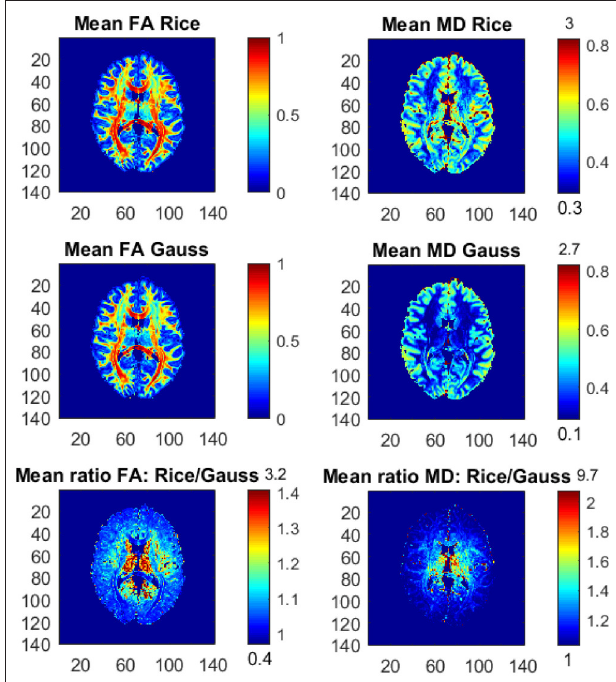
FIGURE 4 | Posterior means and ratios of posterior means of FA and MD for the Rician and Gaussian DTI models, using the part of the dataset with all b -values up to b = 5,000 s/mm 2 . The color bars are shown for the mid 95% values and the minimum and maximum values are marked out at the bottom and top of the color bars,